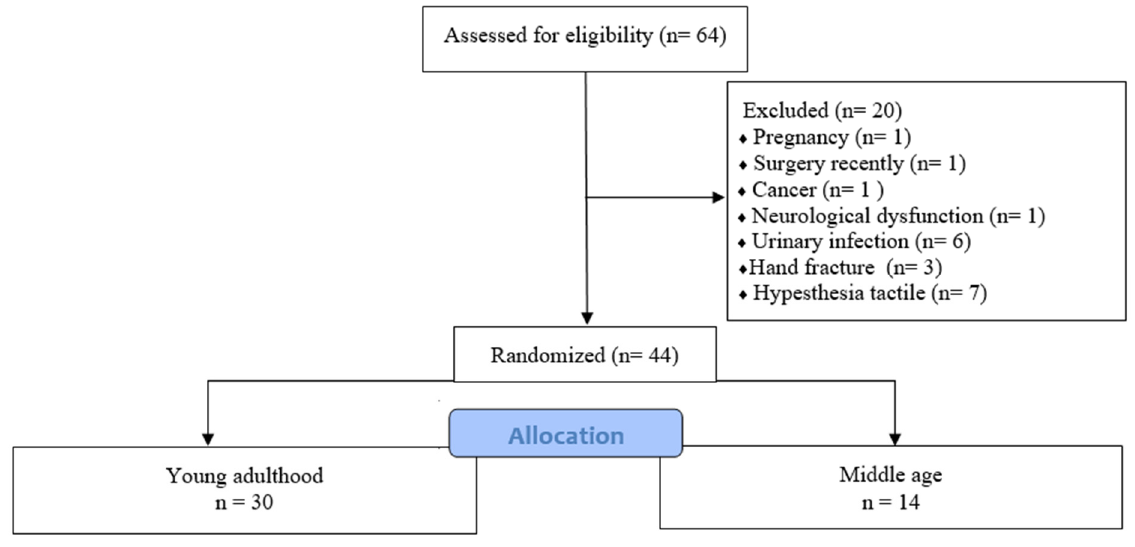
Figure 1. Flowchart of sample eligibility.